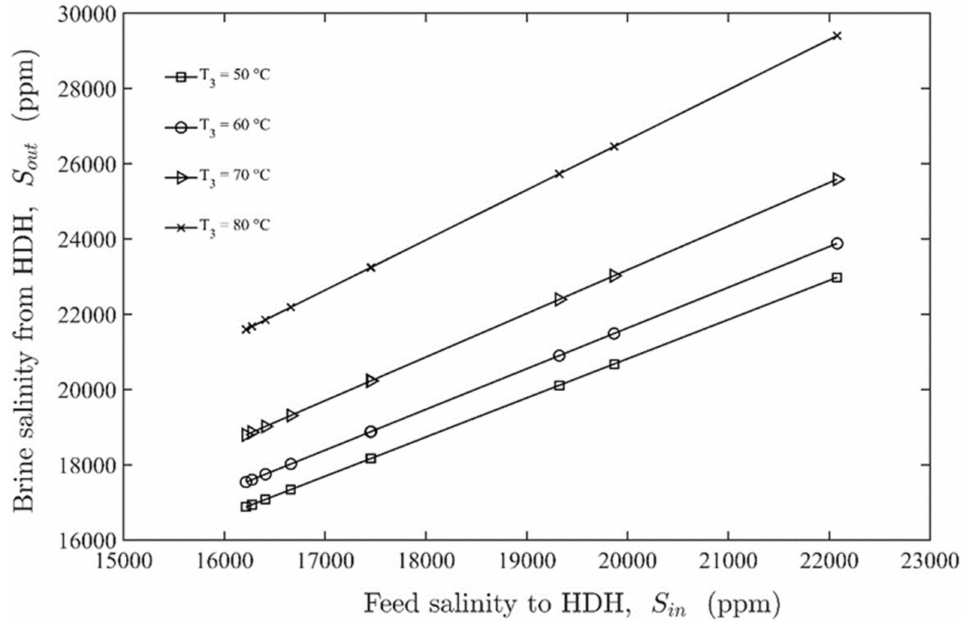
Figure 10. HDH brine salinity vs. CDI brine flow rate at dehumidifier inlet for different humidifier inlet water temperatures in HDH with MR = 3.